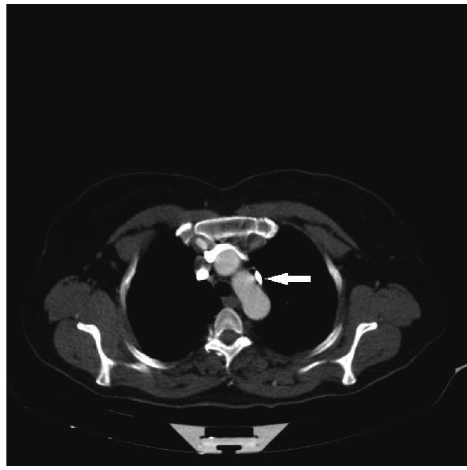
Figure 1: The aneurysmatic ascending aorta had pressured the superior vena cava (arrowhead). Independent right and left azygos veins in axial image (arrows).